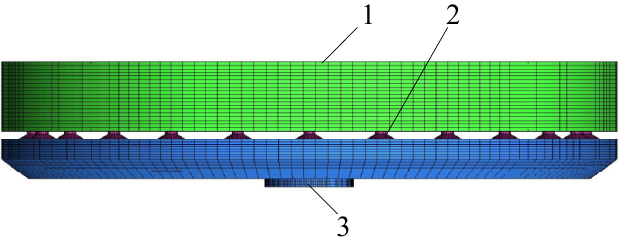
Figure 7. Flow field model: 1. seed storage chamber grid, 2. seed disk hole grid, 3. suction chamber grid. Table 3. Simulation parameters.